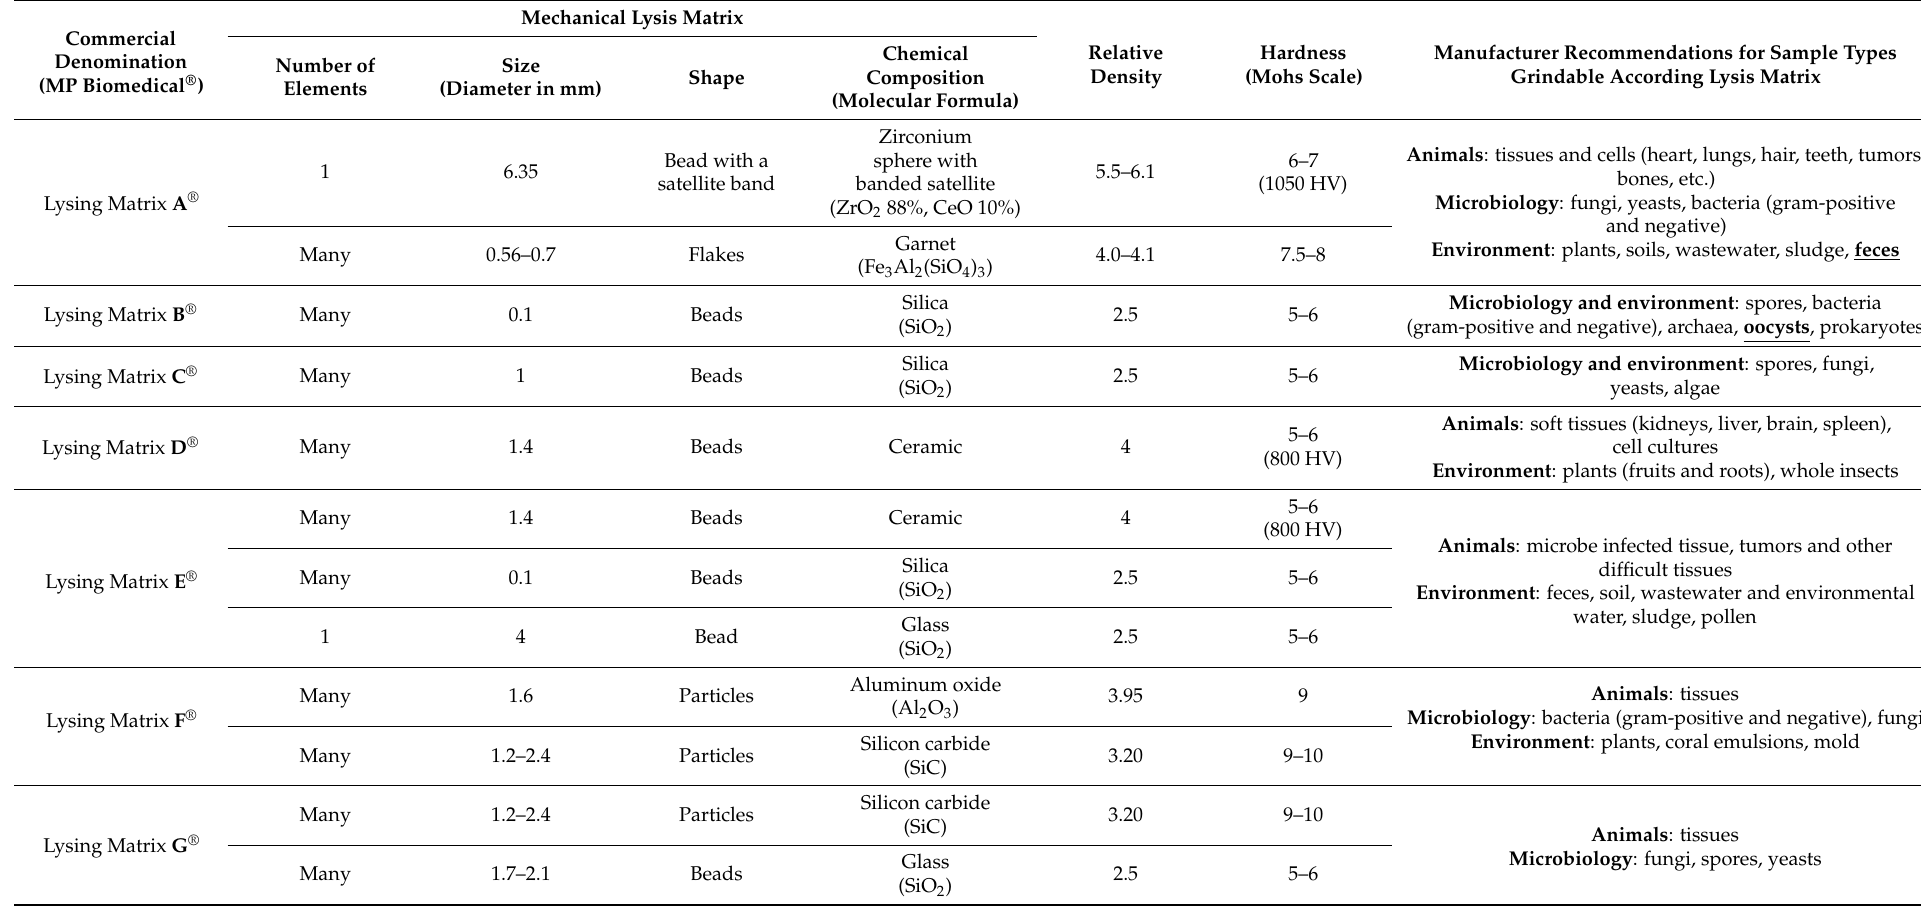
Table 2. The composition and properties of the mechanical lysis matrixes according to data from the manufacturer (MP Biomedical ® ) HV: hardness according to the Vickers